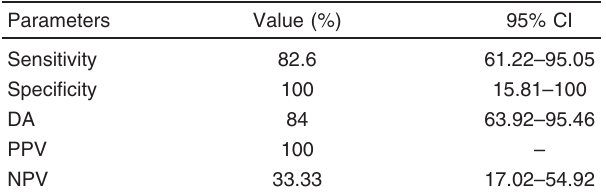
CI, confidence interval; DA, diagnostic accuracy; EBUS-TBNA, endobronchial ultrasound-guided transbronchial needle aspiration; NPV, negative predictive value; PPV, positive predictive